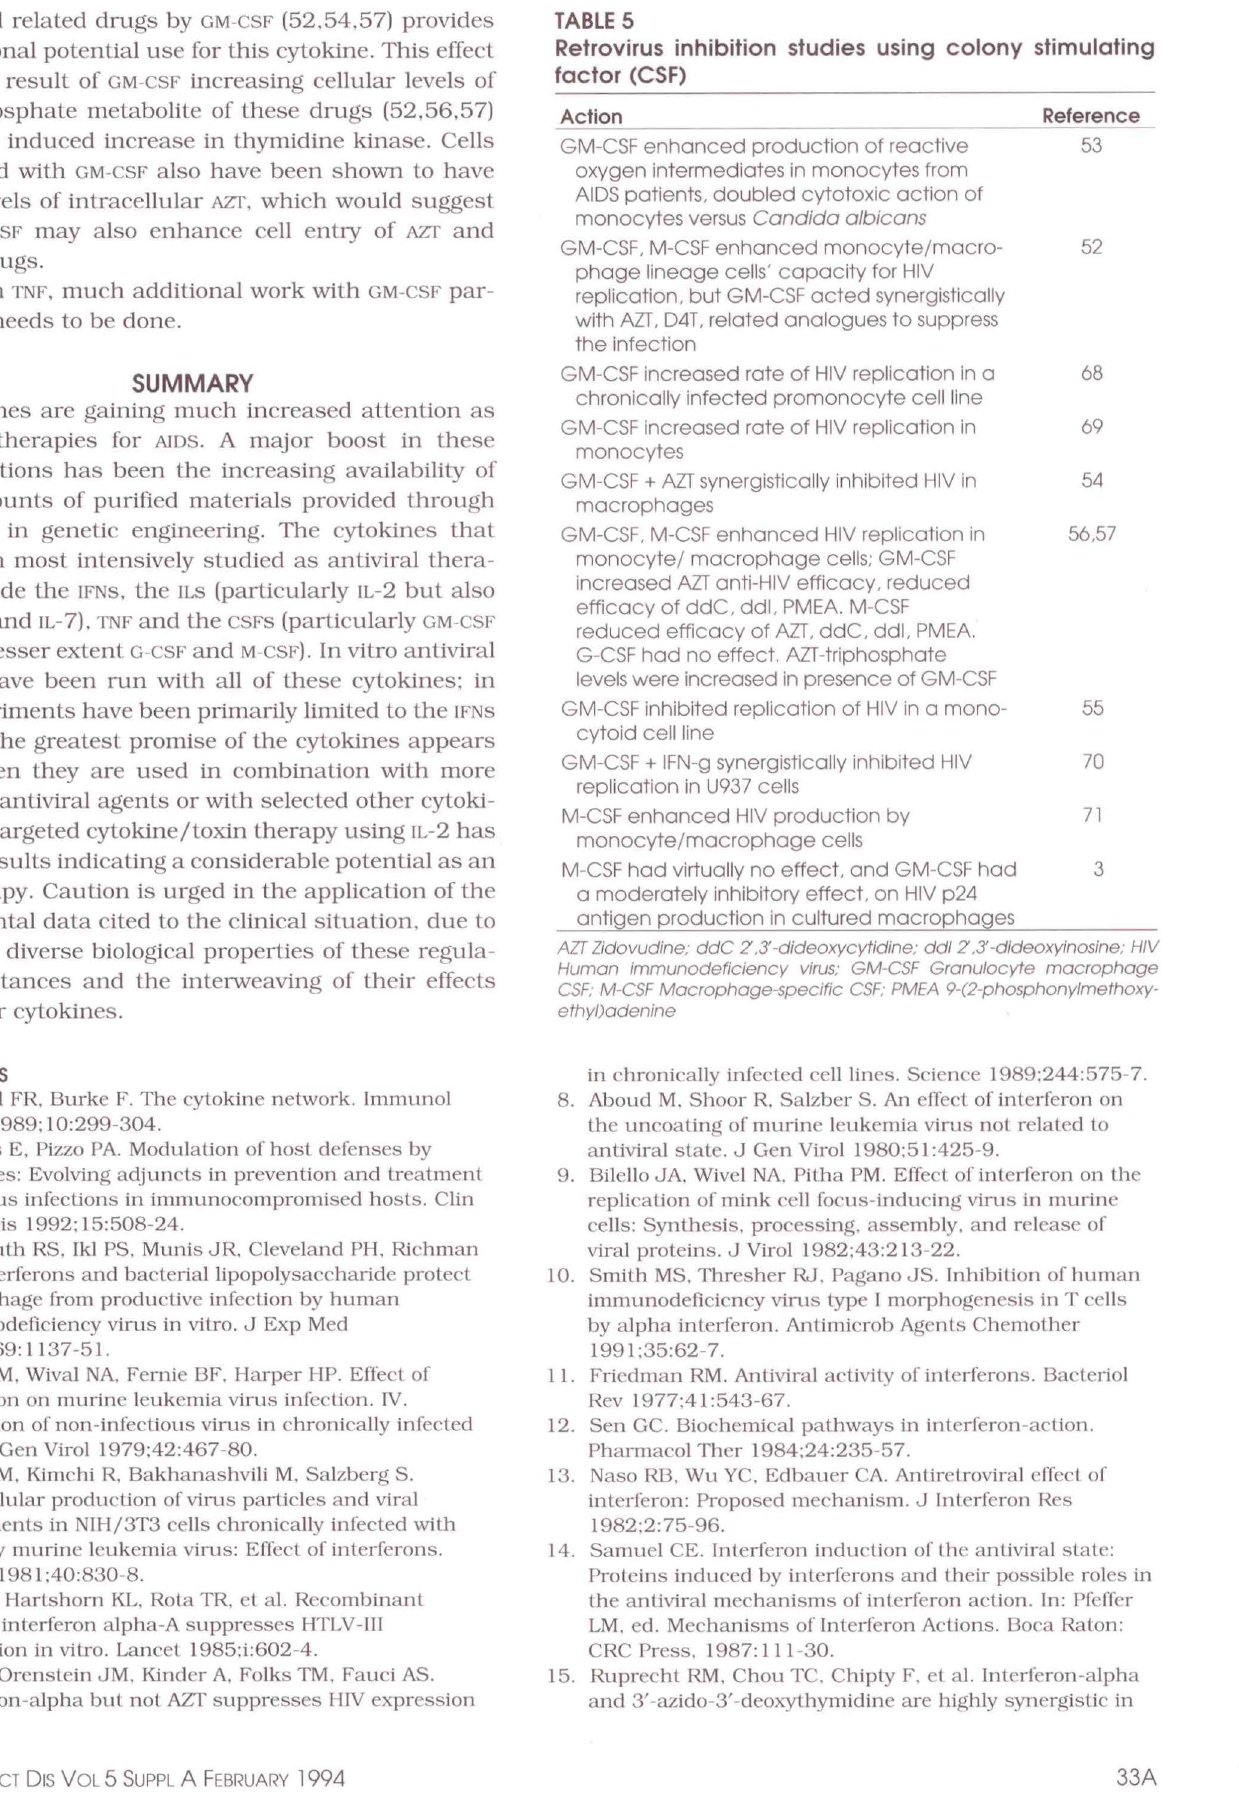
Retrovirus inhibition studies using colony